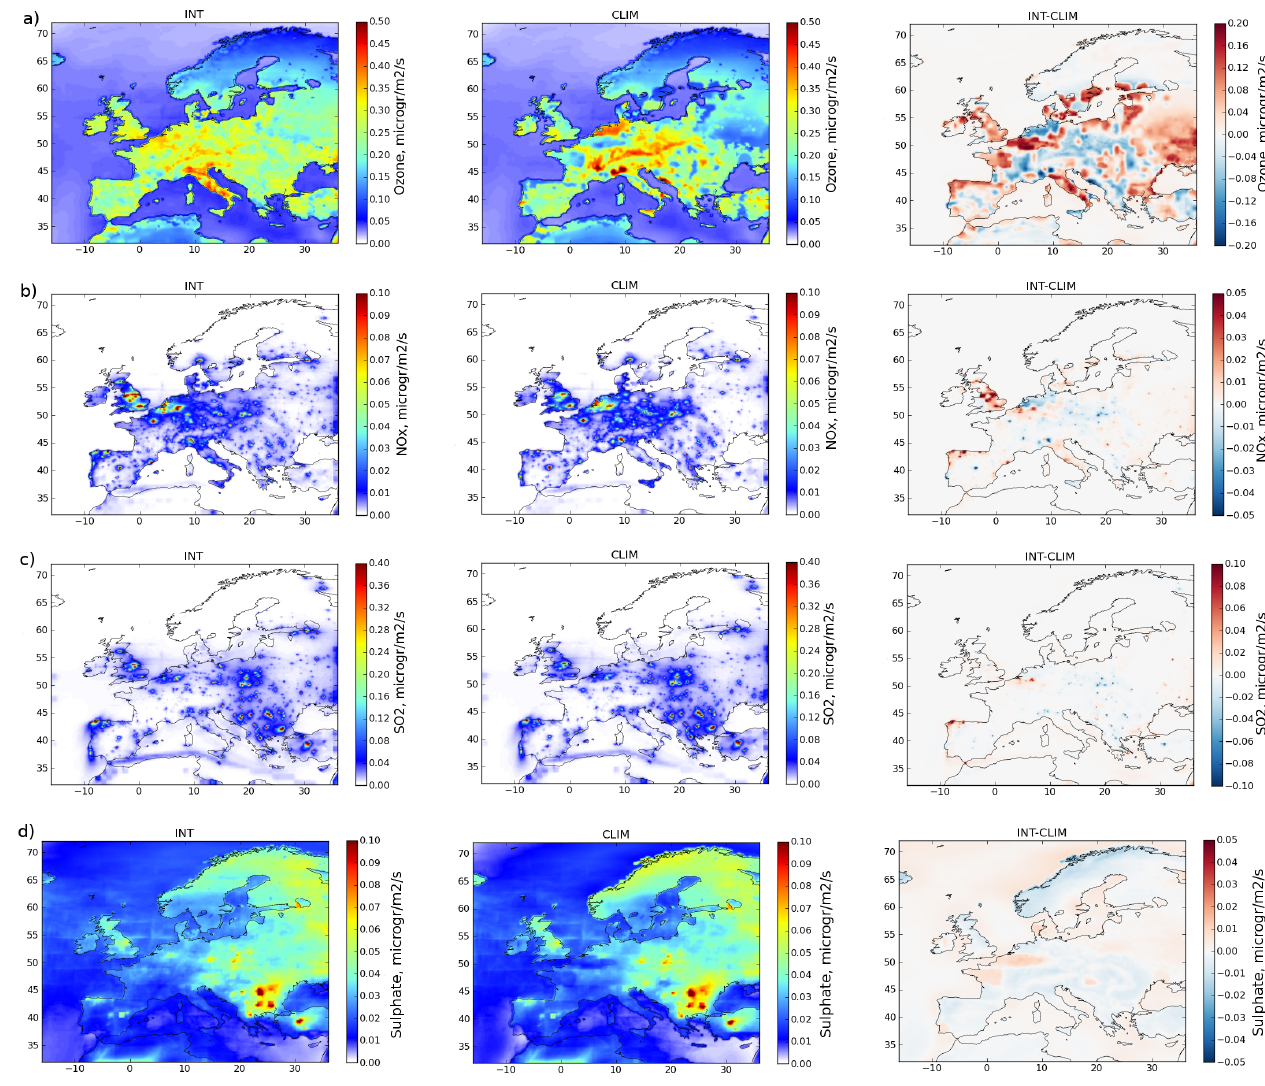
Fig. 8. From top to bottom: (a) deposition flux of O 3 , (b) deposition flux of NO x , (c) deposition flux of SO 2 and (d) deposition flux of sulphate. Deposition flux are in µg m − 2 s − 1 and averaged for the summertime period of INT and CLIM simulations.